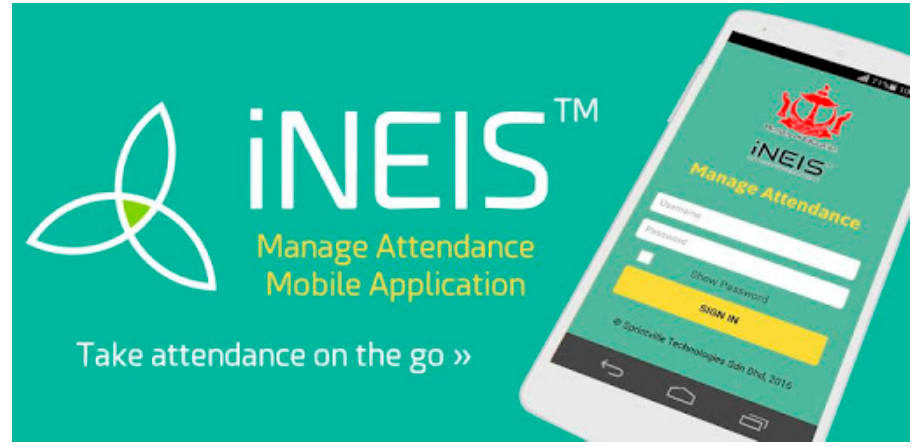
Figure 1. E-Integrated National Education Information System (iNEIS TM ) user interface.